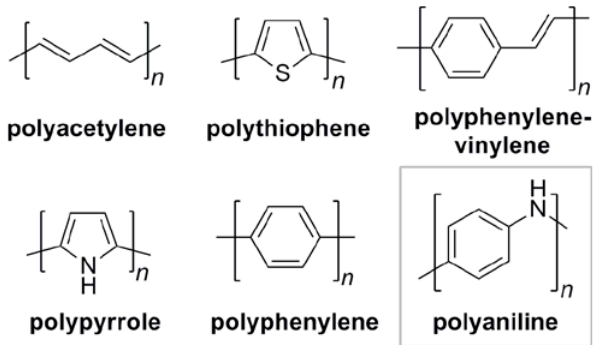
Figure 1. Common parent conjugated organic polymers.